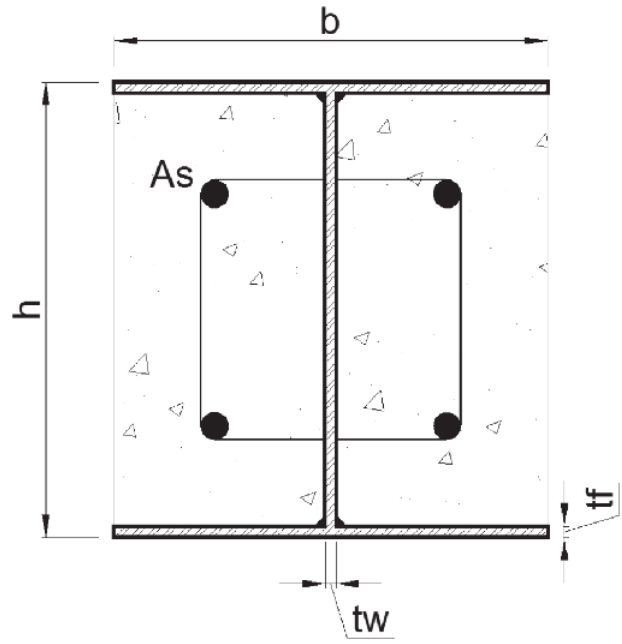
Cross-section of partially encased steel-concrete composite column